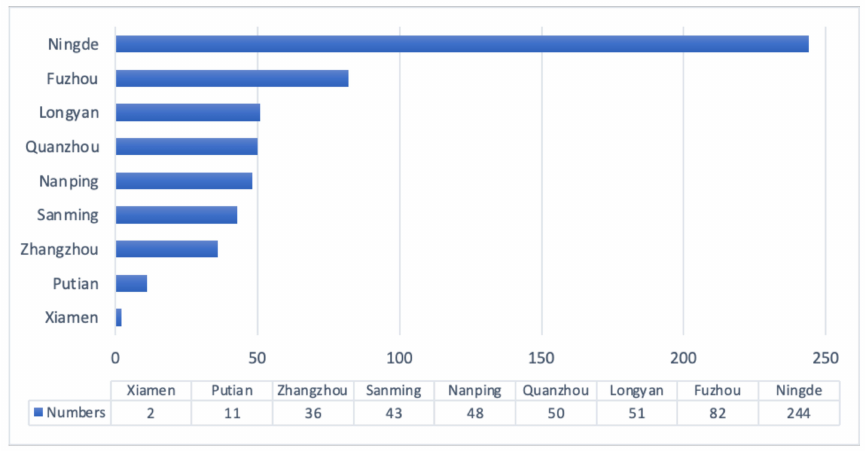
Figure 2. Statistical diagram of the number of ethnic minority villages in cities of Fujian